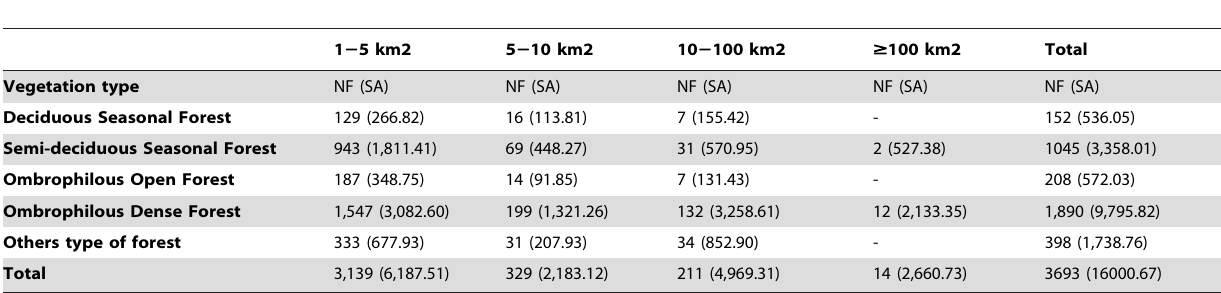
Table 3. Number of forest fragments (NF) and summed areas (SA) in km 2 predicted by the potential geographic distribution models of maned sloth ( Bradypus torquatus ), according to vegetation type and area.